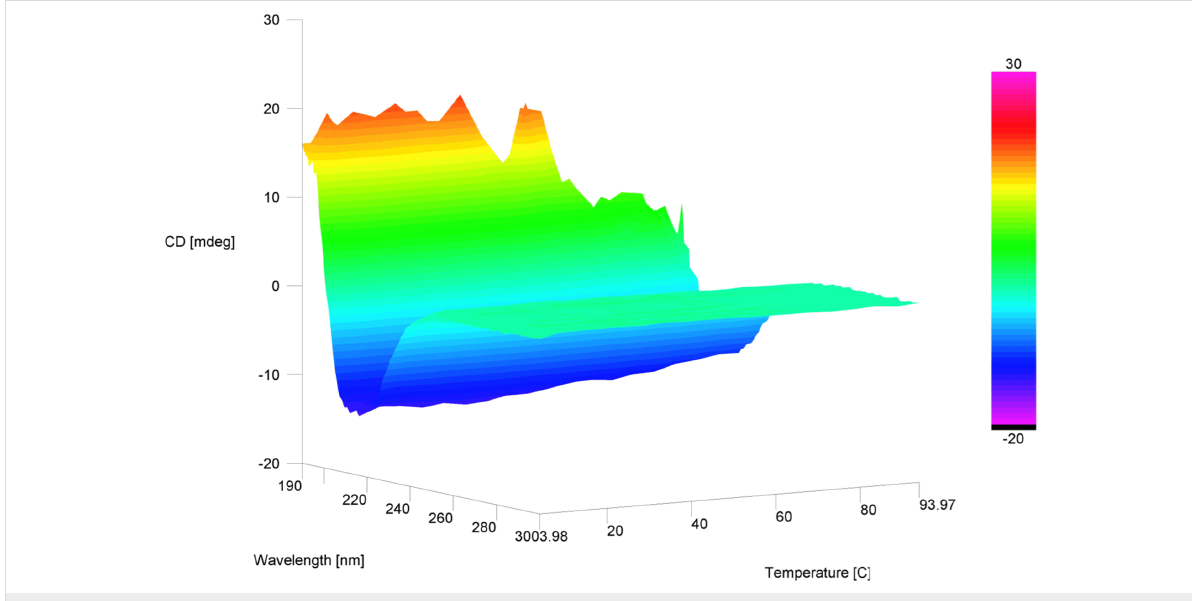
Figure 2: Temperature-dependent CD spectra of catalyst 17 .